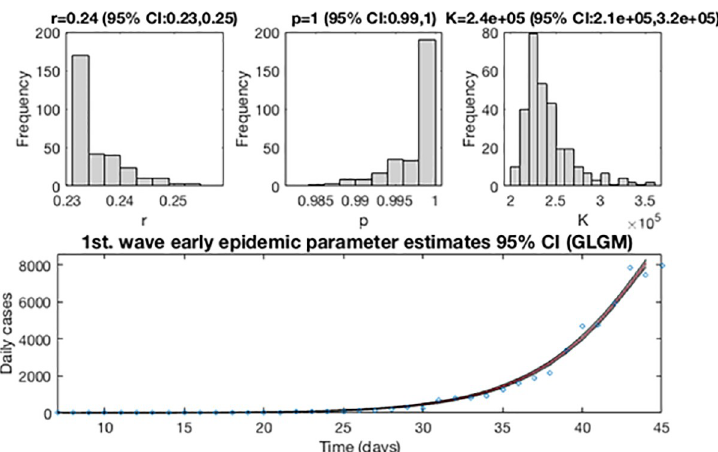
Fig 6. Resulting curves after re-fitting of parameters of the early epidemic phase. Blue circles are the cases reported daily; red line corresponds to the best fit of the GLGM to the data. Grey lines correspond to the m bootstrapping realizations of the epidemic curves. Black lines correspond to the 95% CI bounds. The empirical distributions for parameter estimations are displayed in the top panel.